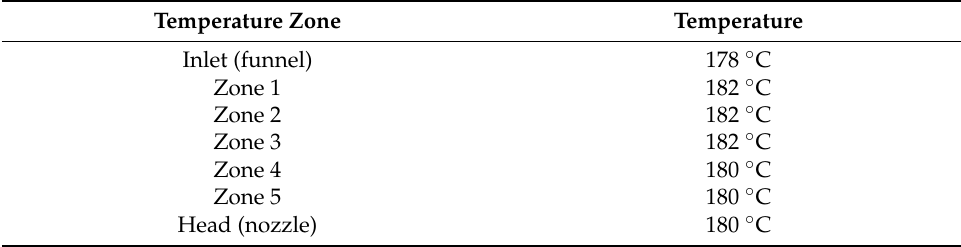
Table 3. Temperature zones of the